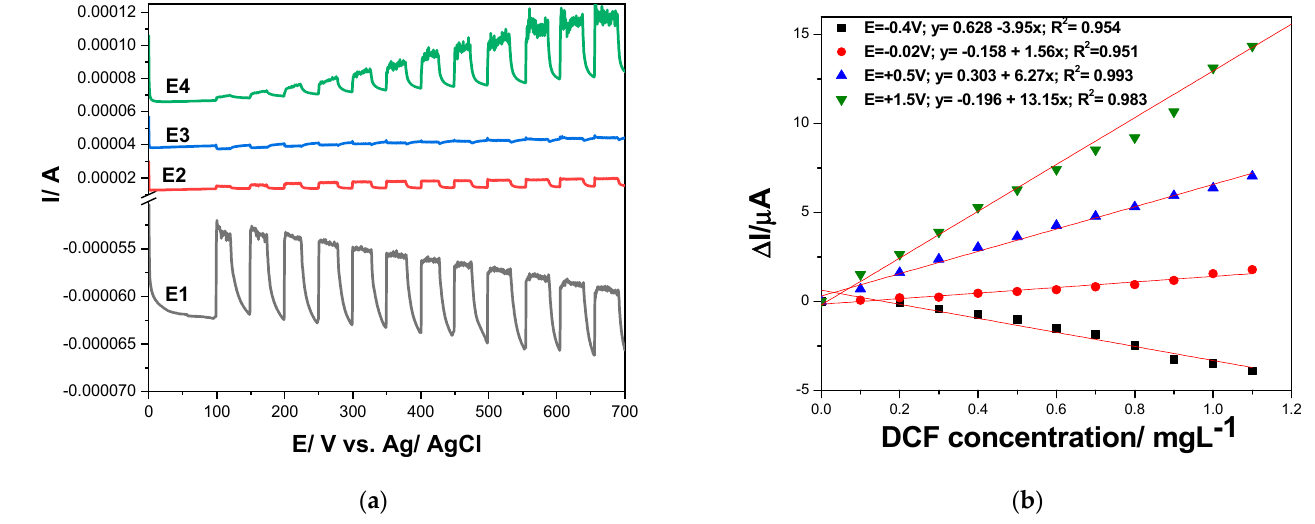
Figure 8. ( a ) Multiple-pulsed amperograms recorded by GR-CNT electrode in 0.1 M Na 2 SO 4 supporting electrolyte and 0.100 mg·L − 1 DCF added consecutively and continuously, recorded at E1 = − 0.400 V vs. Ag/AgCl, E2 = − 0.020 V vs. Ag/AgCl, E3 = +0.500 V vs. Ag/AgCl, and E4 = +1.50 V vs. Ag/AgCl. ( b ) Calibration plots of the currents recorded at E = − 0.400 V vs. Ag/AgCl, E = − 0.020 V vs. Ag/AgCl, E = +0.500 V vs. Ag/AgCl, and E = +1.50 V vs. Ag/AgCl versus diclofenac concentrations.